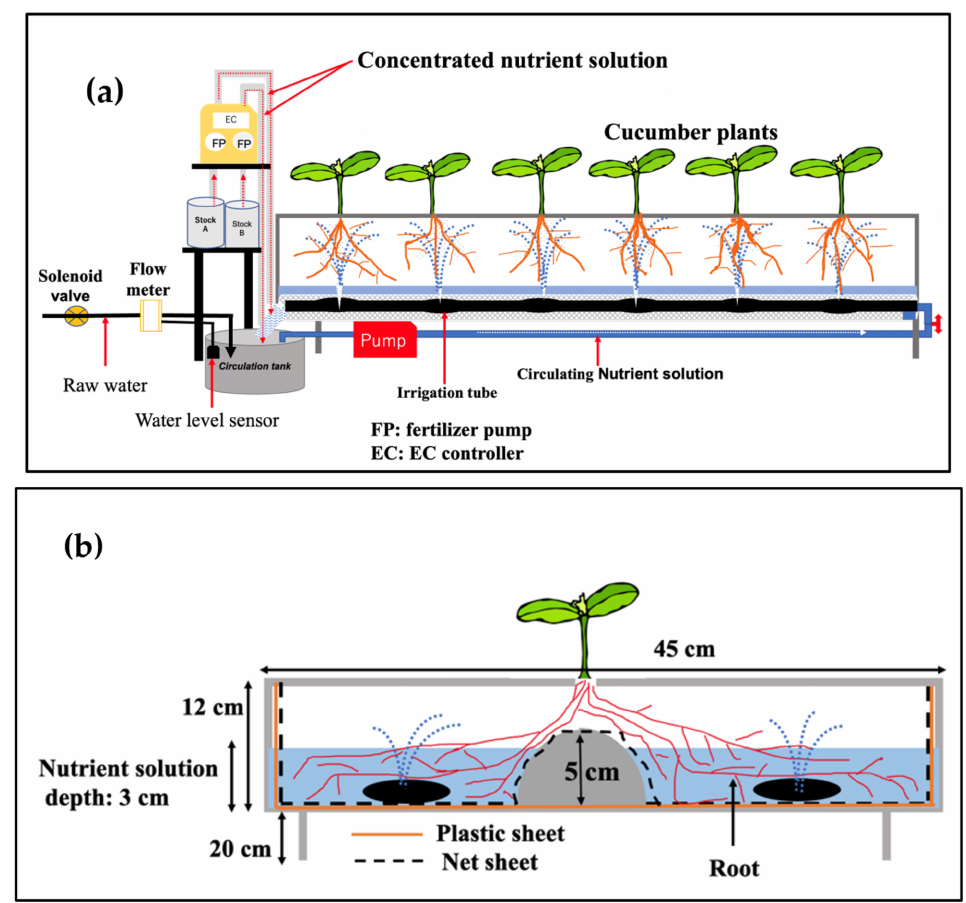
Figure 1. Schematic diagram of the NFT hydroponic system: lateral ( a ) and front ( b ) view.